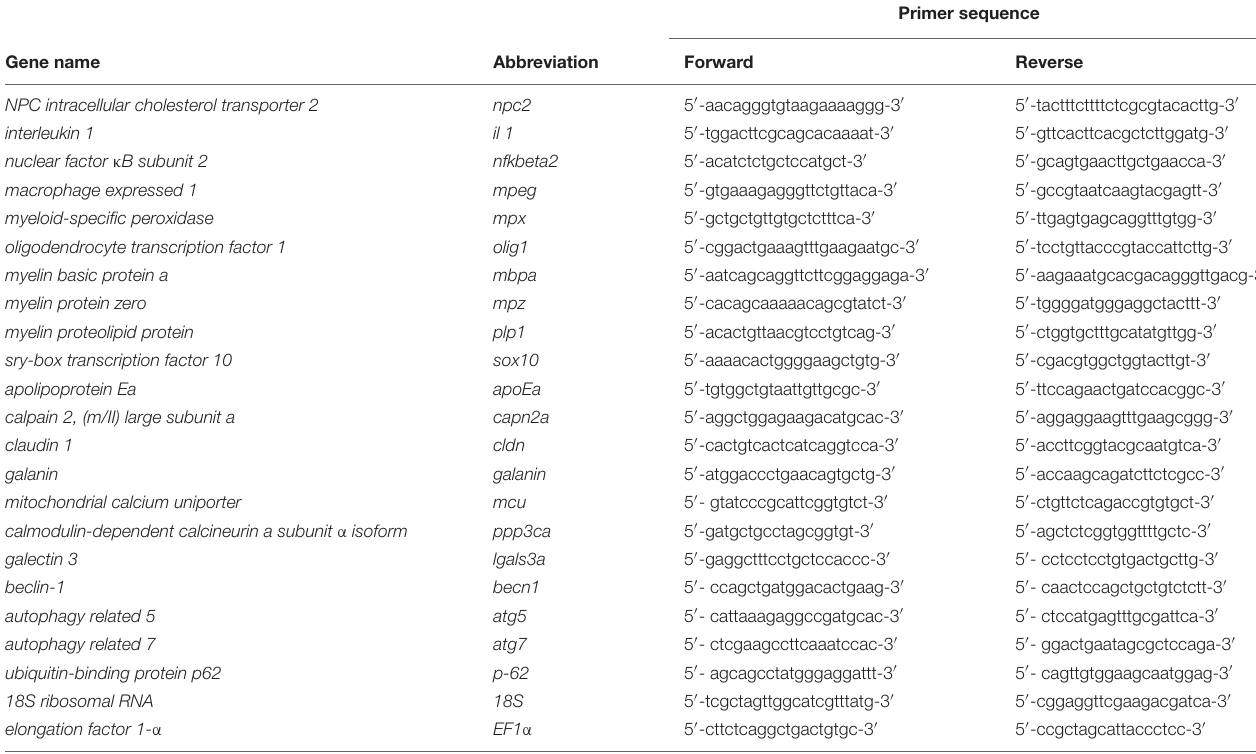
TABLE 1 | List of primers used for gene expression